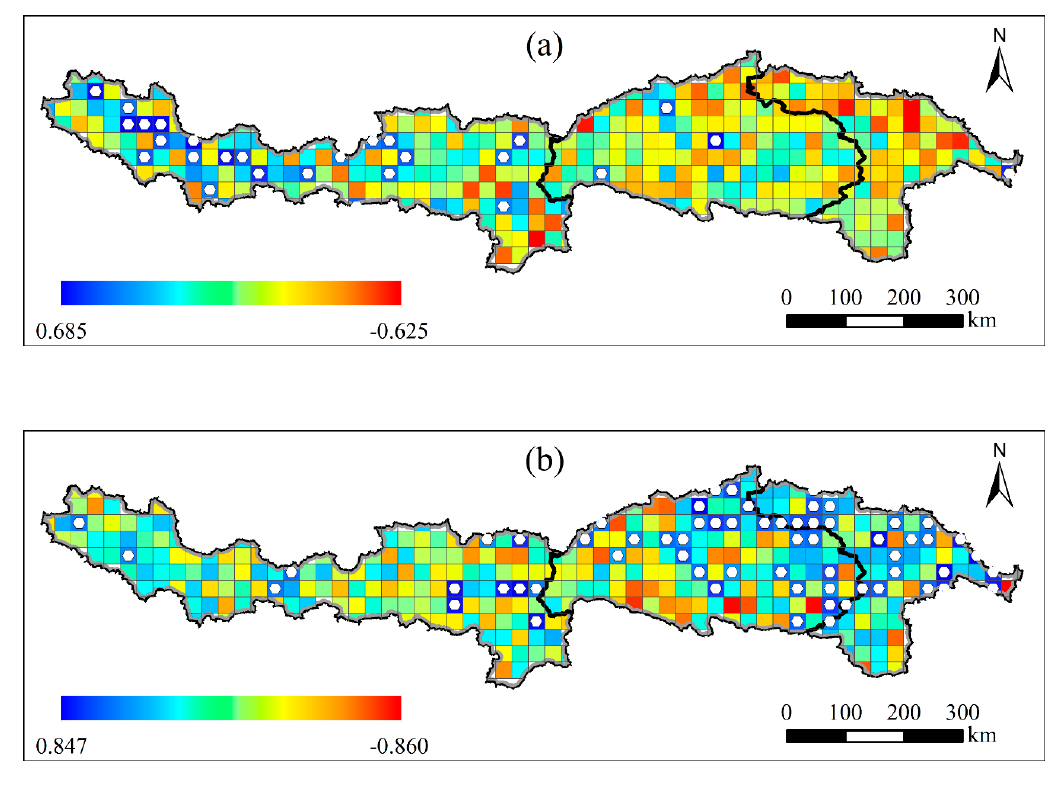
Figure 7. The spatial distribution of the correlation coefficient between NDVI and precipitation ( a ) and NDVI and temperature ( b ). The white point represents a significantly positive correlation at the 0.05 significance